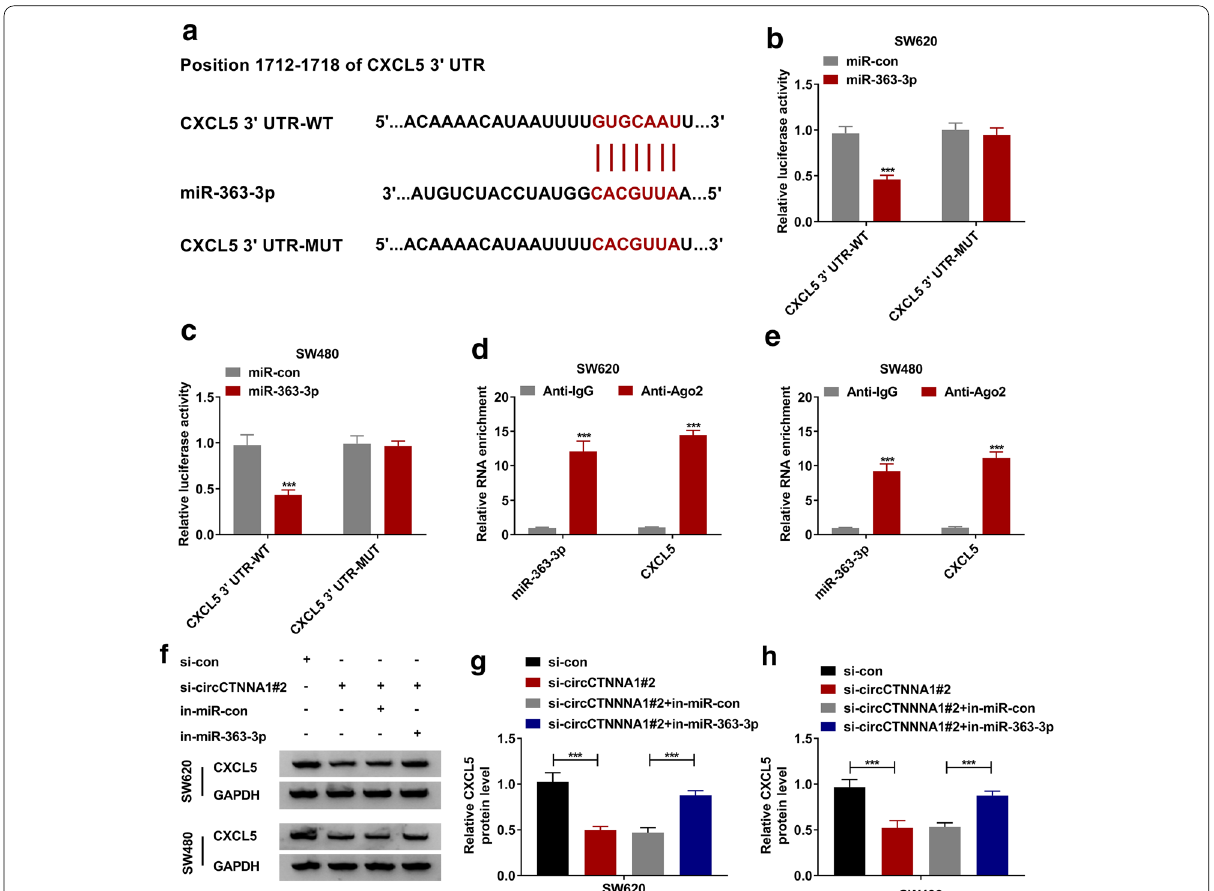
Fig. 5 MiR-363-3p directly targeted CXCL5. a The binding sites between CXCL5 3 ′ UTR and miR-363-3p were exhibited. The interaction between CXCL5 and miR-363-3p was confirmed by dual-luciferase reporter assay ( b , c ) and RNA immunoprecipitation assay ( d , e ). f – h SW620 and SW480 cells were transfected with si-con, si-circCTNNA1#2, si-circCTNNA1#2 CXCL5 was detected by WB analysis. *** p <